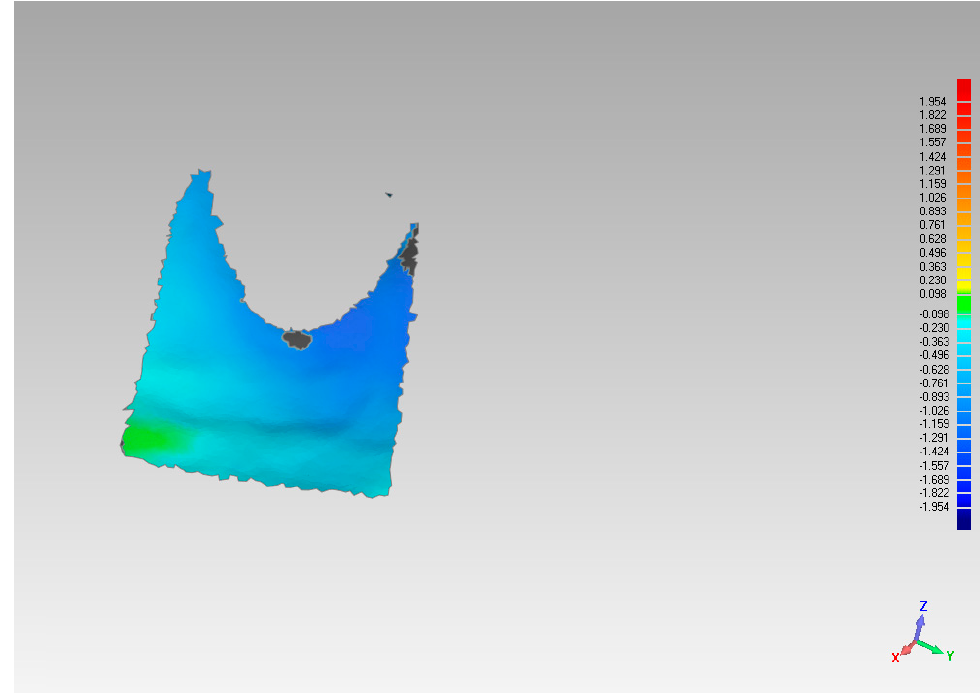
Figure 7. Analysis of vestibular variation in the pre-implant placement model compared to the pre-extraction model.